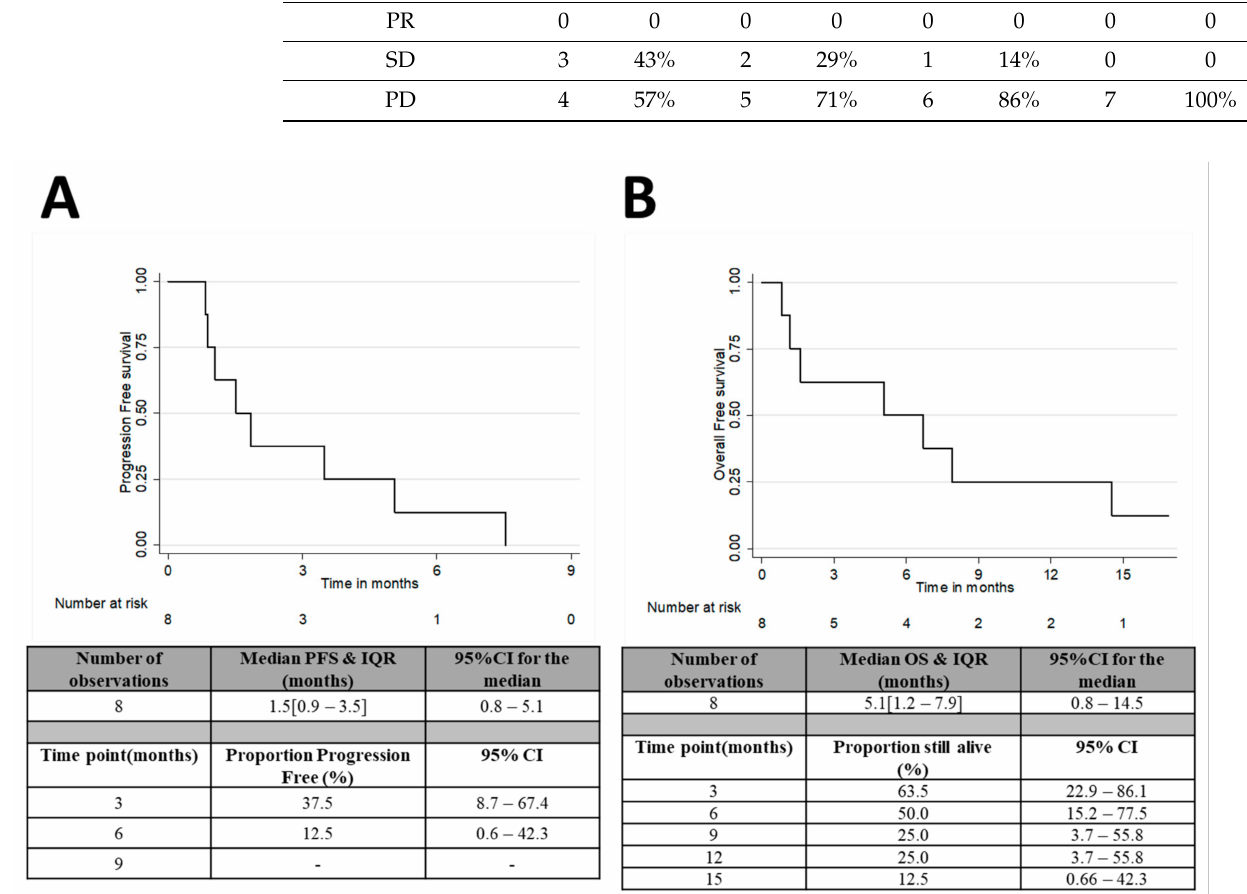
Figure 2. ( A ) Progression free survival and ( B ) overall survival in the treated